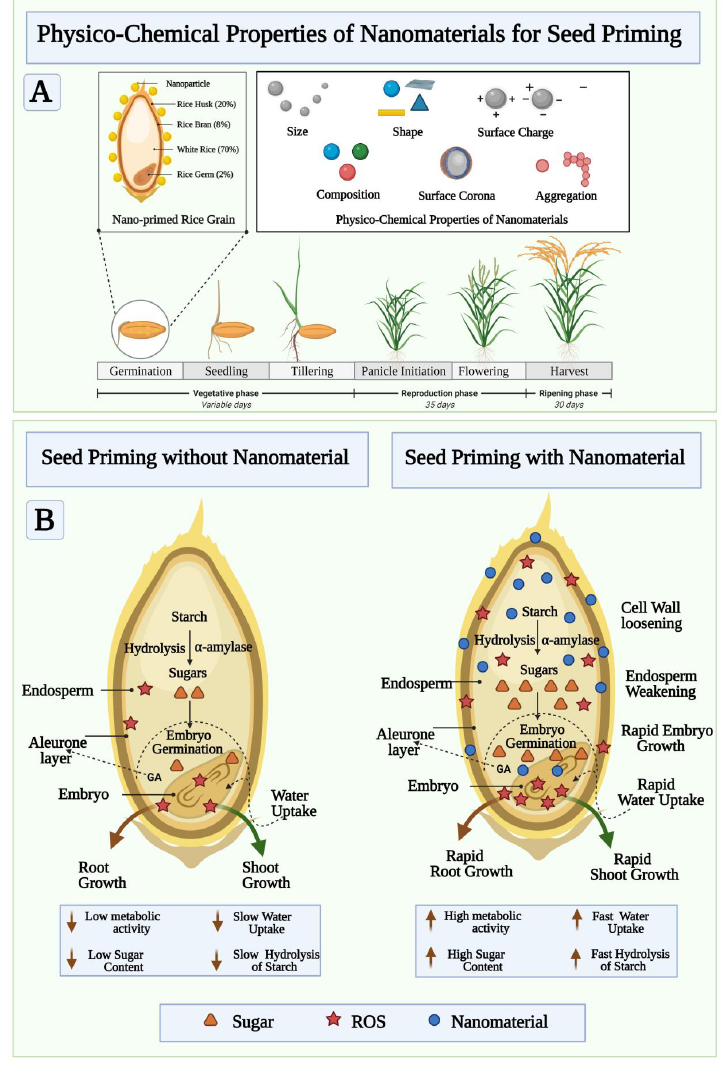
Figure 2. Physicochemical properties of nanomaterials influencing seed priming and its proposed mechanism. ( A ) The nanomaterial’s size, shape, and surface chemistry make them a versatile candidate to modulate the seed priming phenomena via size-mediated diffusions and relocating to specific regions of the seed to activate synergistic mechanisms resulting in germination. ( B ) The versatile catalytic function of NMs selectively play role in promoting enzymatic and biochemical pathways to promote root/shoot growth.